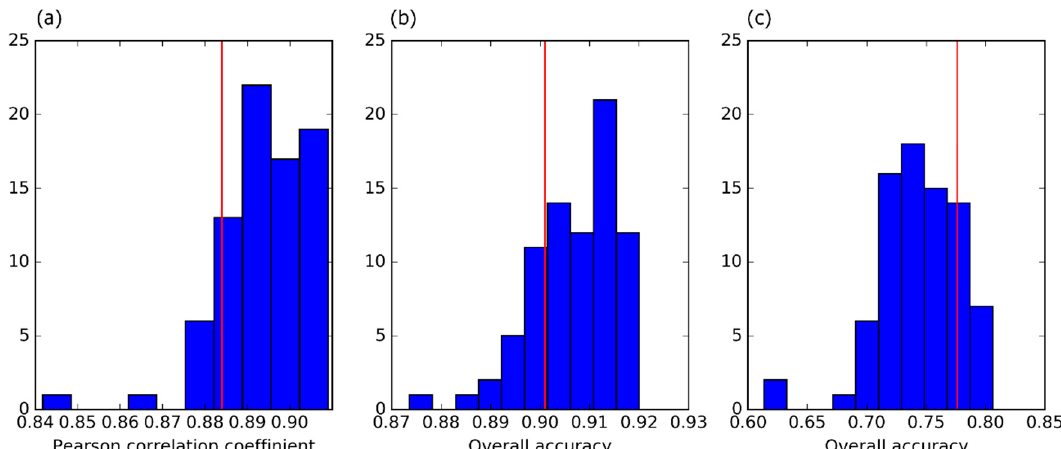
Figure 16. Validation results distribution of the model sensitivity test. Sensitivity of the method to the selection of the location of the signature prototypes was tested using 80 sets of reference points. Validation metrics were computed between the respective Sentinel-1 forest maps and Copernicus High Resolution Layers forest maps. Histograms show ( a ) Pearson correlation coefficient of the tree cover density maps, ( b ) overall accuracy of the forest/non-forest classification and ( c ) overall accuracy of the coniferous/broadleaf forest type classification. Red lines indicate the values computed using the original set of signature prototypes.